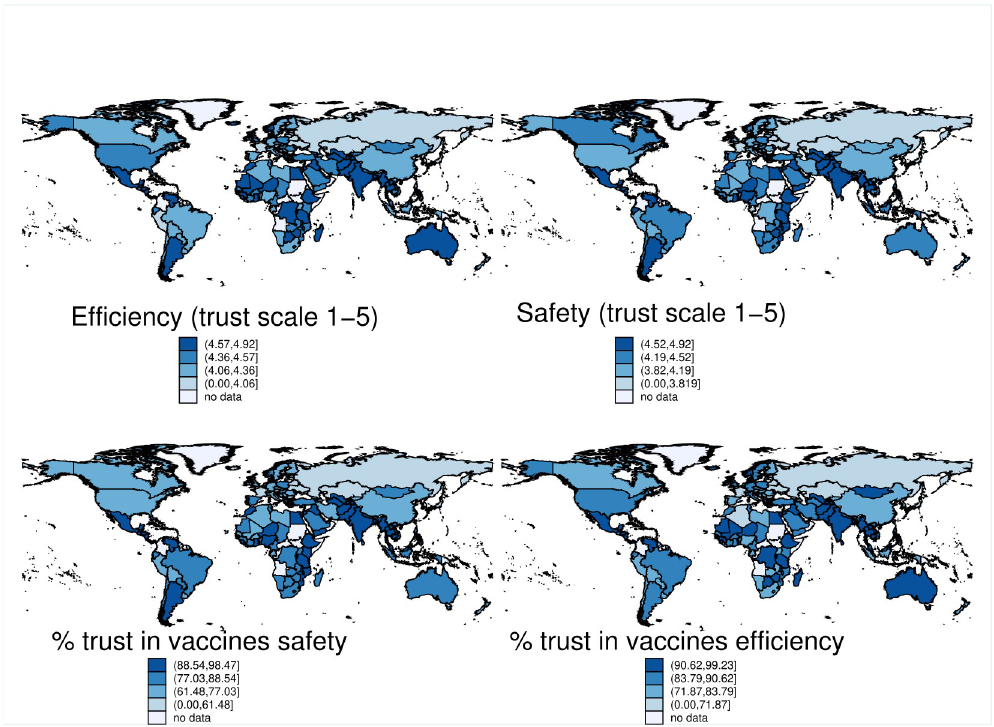
Fig 1. Trust in vaccines efficiency and safety in the countries of the world. Notes : The above maps were prepared using resources on country boundaries released by the World Bank and available in the public domain. The sample is split in quantiles according to the value of the variable. The colour indicates the quantile as shown in the legend. Source : WGM 2018.